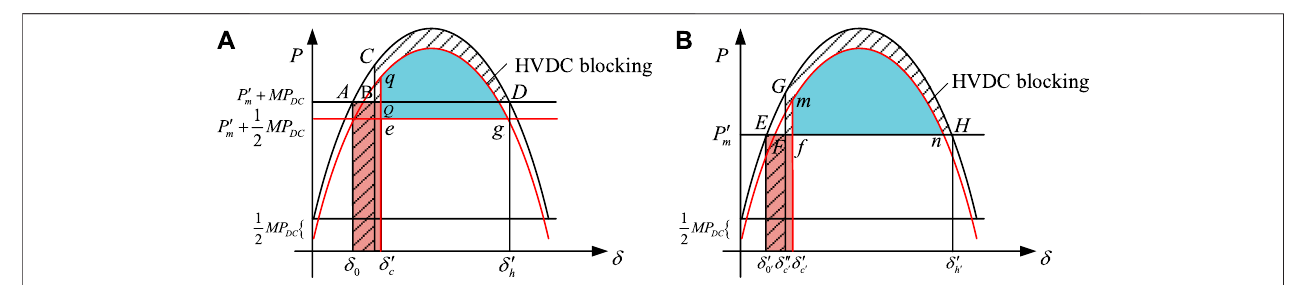
FIGURE 8 | Power characteristic curve of single HVDC blocking (A) the AC operating point remains unchanged (B) the total transmission power remains unchanged.